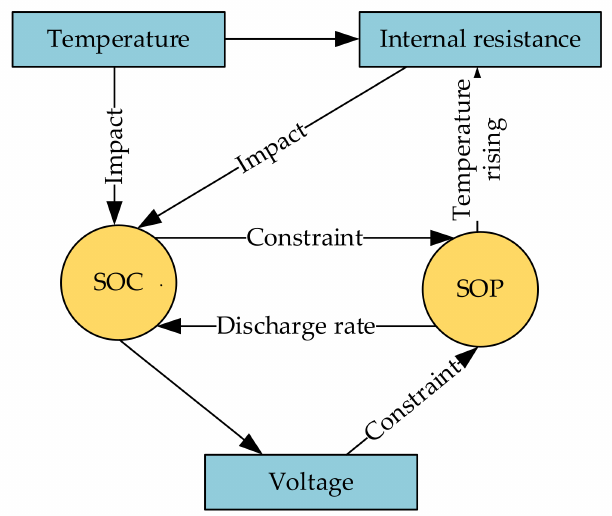
Figure 17. The relationship between SOC and SOP. Table 8. SOP-estimation methods based on 2RC model with multiple